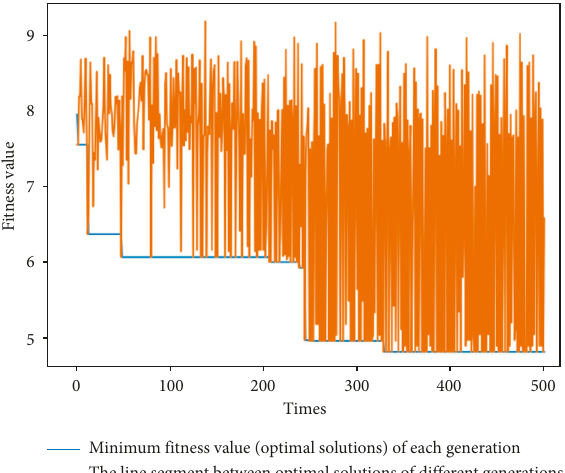
Figure 4: Minimum fitness of children and